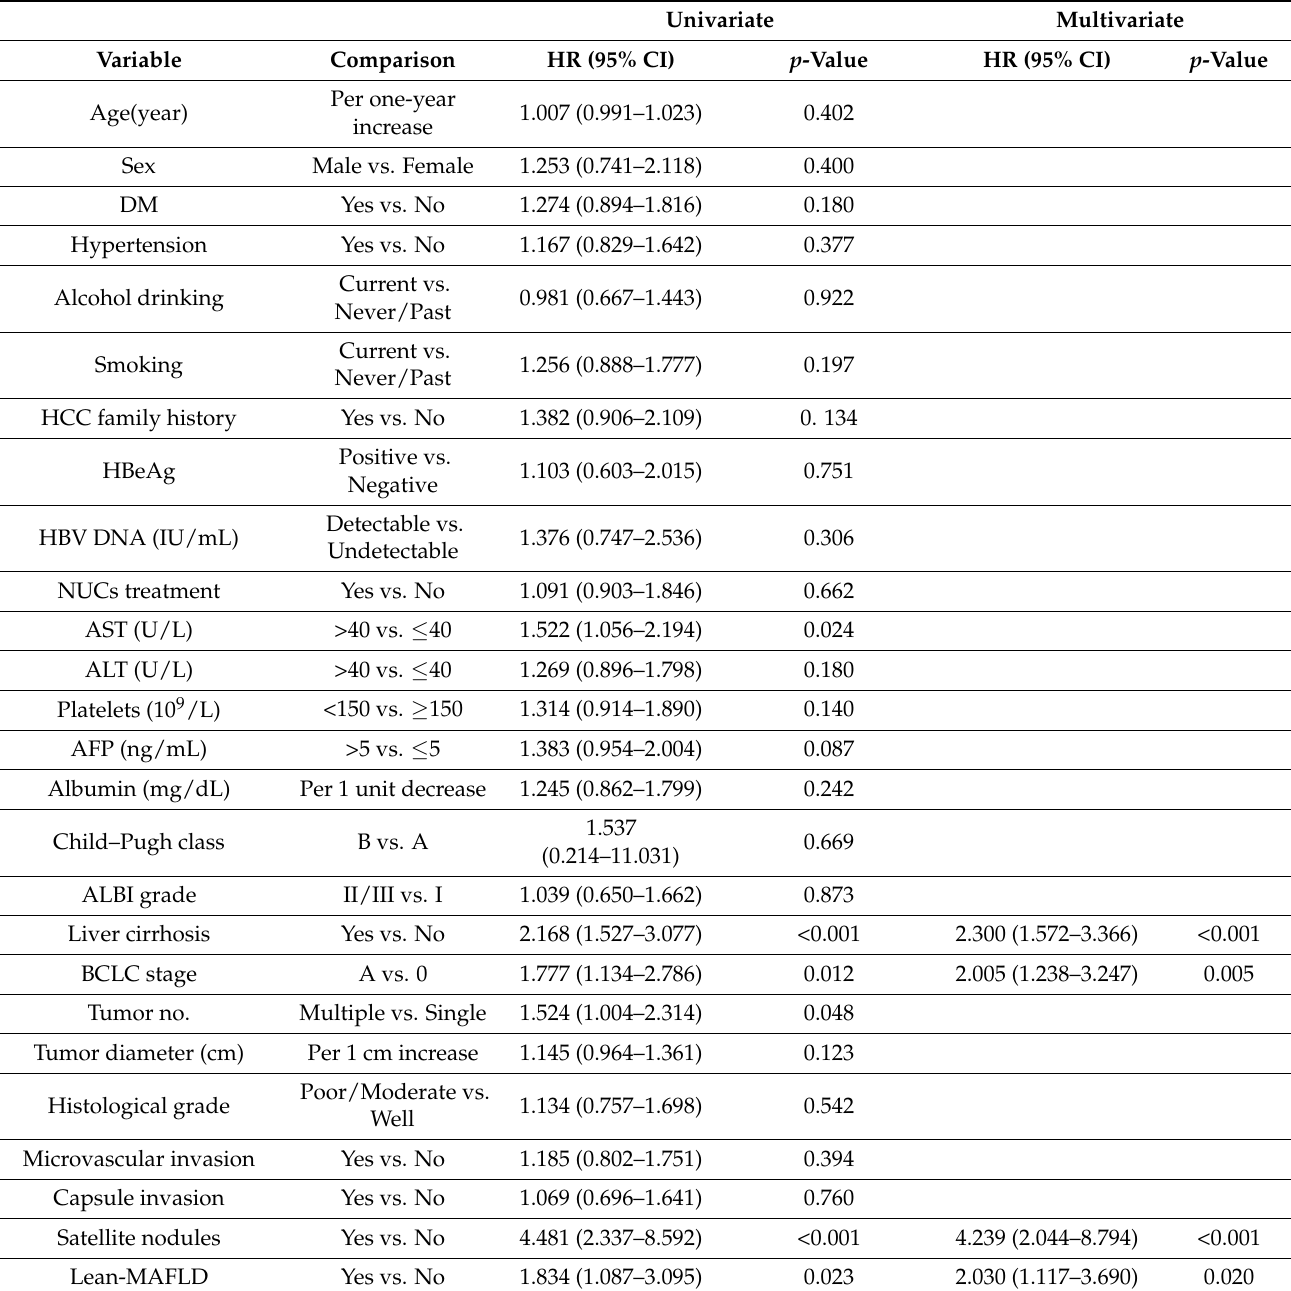
Table 4. Prognostic factors for HCC recurrence in the MAFLD group ( n = 368). Univariate